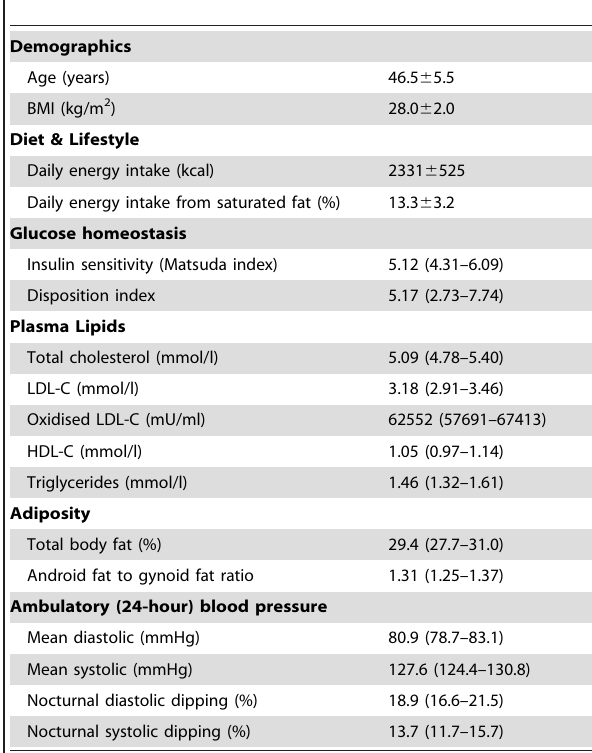
Table 2. Baseline data on the study population (n= 45). Data are mean 6 SD, or adjusted means from multivariate models with respective 95% confidence